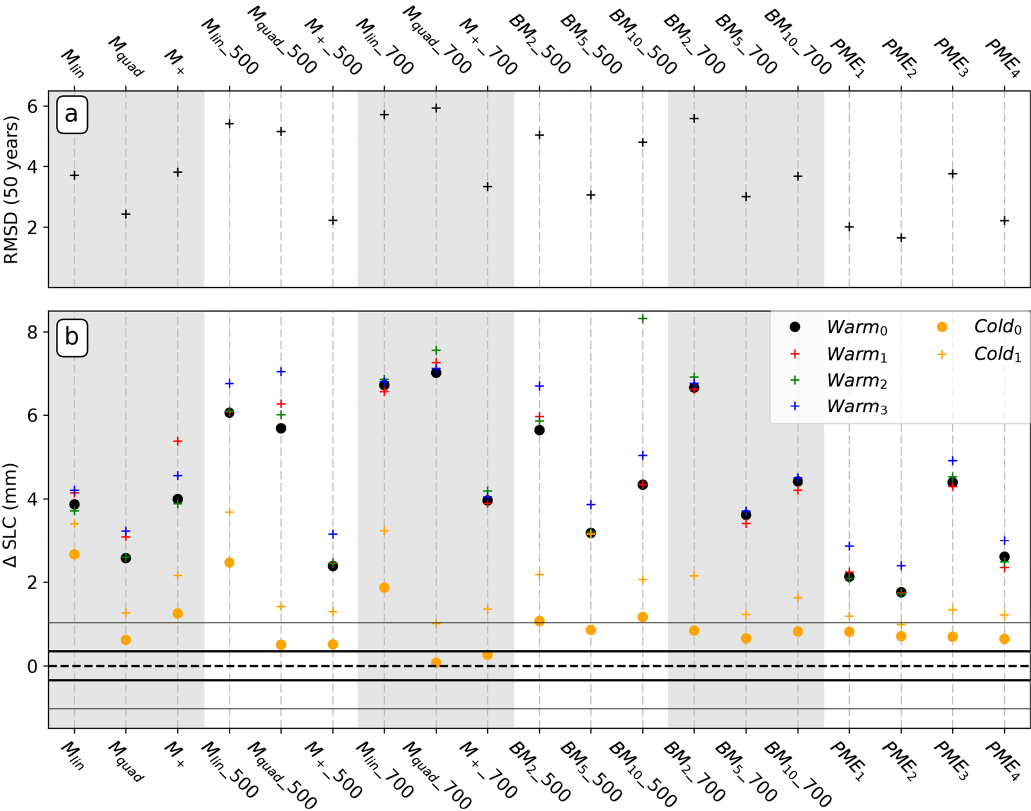
Figure F1. Same as Fig. 9 but for an initial calibration based on averaged melt rates below 300m